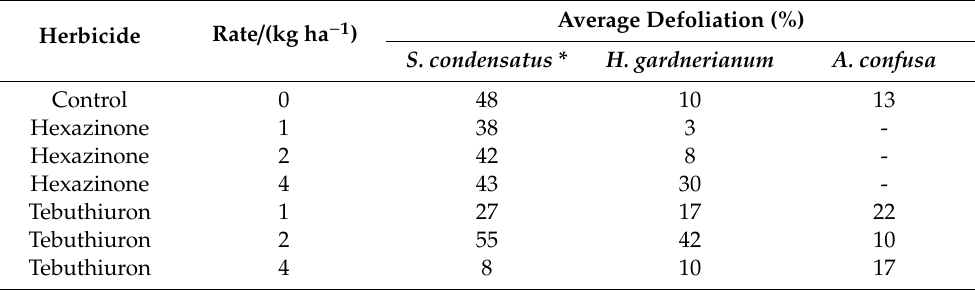
Table 1. Response of the major invasive weeds bush beardgrass ( Schizachyrium condensatum ), kahili ginger ( Hedychium gardnerianum ) and Formosan koa ( Acacia confusa )) to soil-applied with hexazinone and tebuthiuron, 9